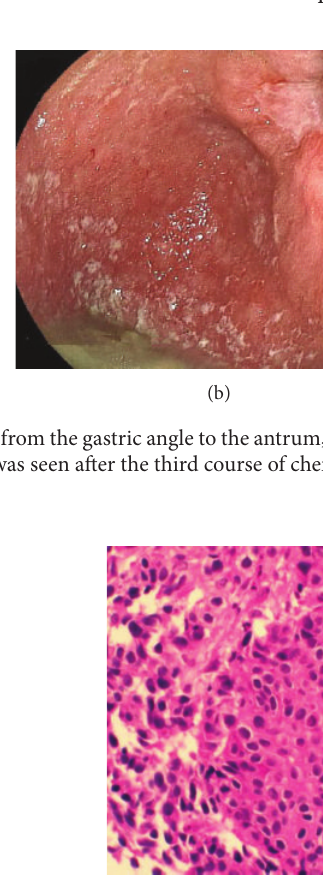
Figure 2: Histological analysis of the biopsy specimen. Microscopic examination showed a poorly differentiated